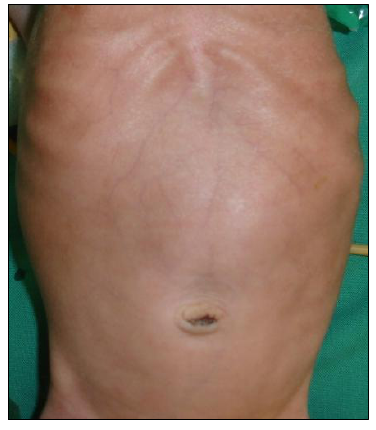
Figure 1: Upper abdominal distension due to dilated stomach with visible